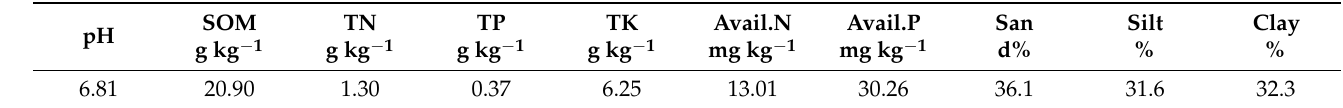
Table 1. Physical and chemical properties of